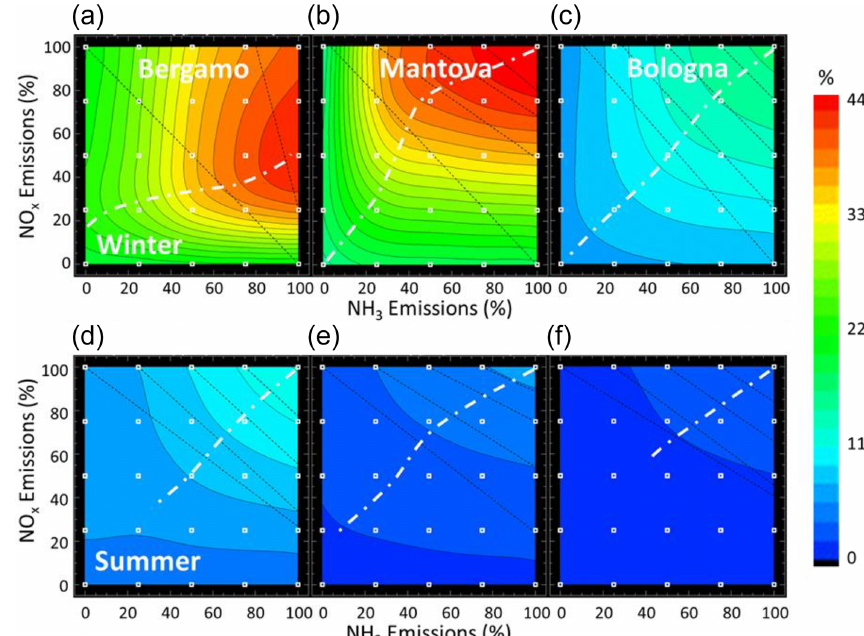
Figure 6. PM 2 . 5 isopleths during winter (a, b, c) and summer (d, e, f) at the three locations of interest (see maps). PM 2 . 5 concentrations are expressed in µgm − 3 as a function of the intensity of the NO x ( y axis) and NH 3 ( x axis) emissions, respectively. The overlaid dashed oblique lines on each diagram connect similar PM 2 . 5 concentration values for single NO x and NH 3 reductions. The more vertical these lines are, the larger the NH 3 abatement impact compared to the NO x abatement impact is; the more horizontal they are, the larger the NO x abatement impact compared to the NH 3 abatement impact is. The dashed line delineates the ridge between the NH 3 - and NO x -sensitive